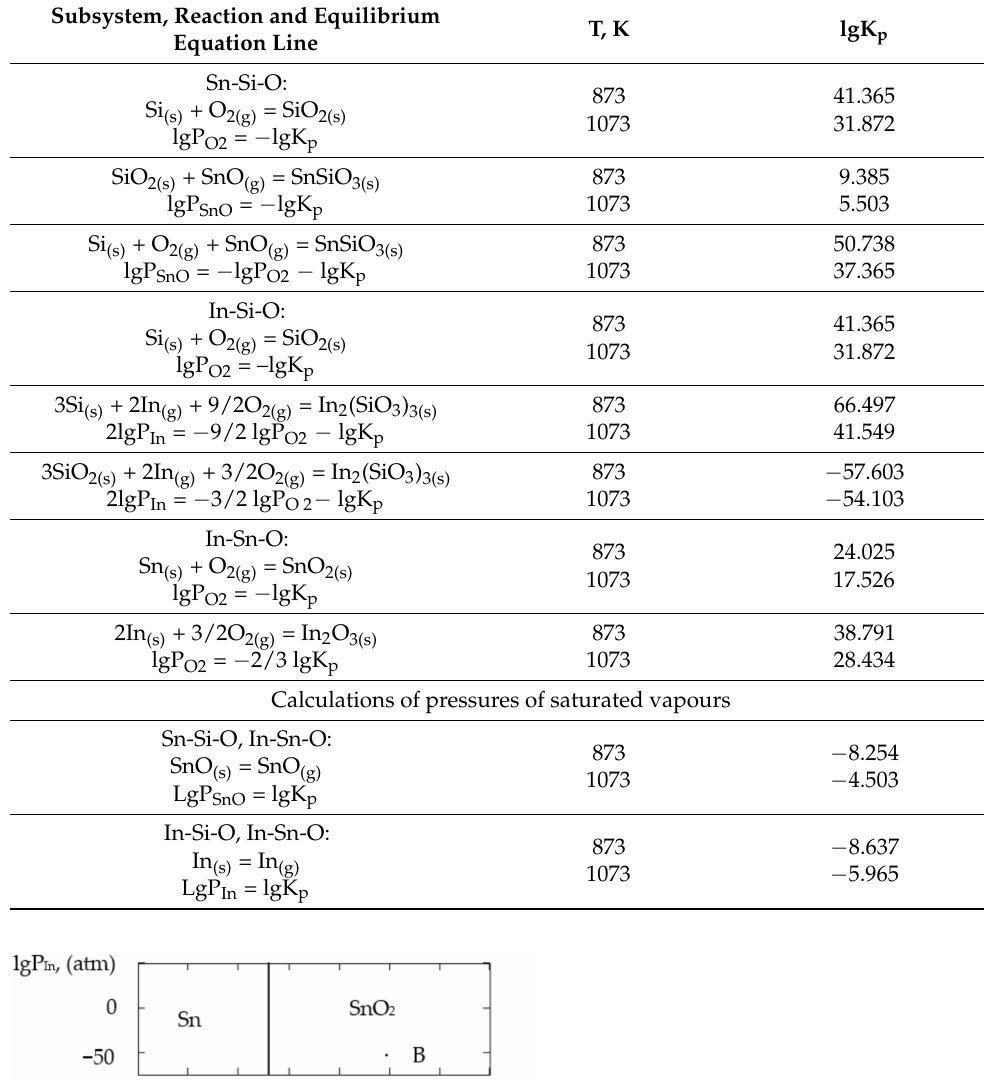
Table 6. Results of calculations of equilibrium reaction constants.